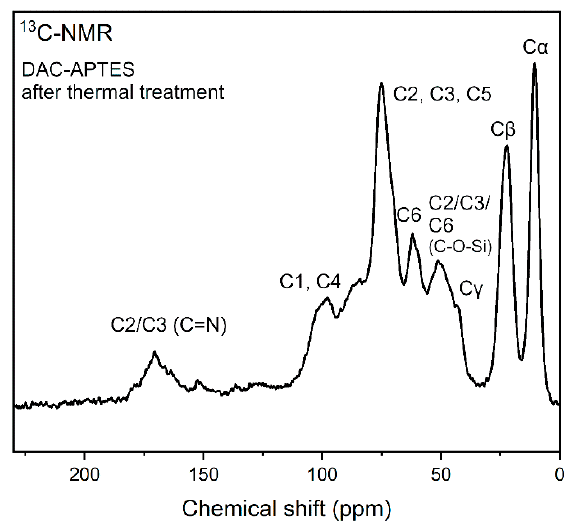
Figure 6. 13 C CP / MAS NMR spectrum of DAC-APTES after thermal treatment. The numbering refers Figure 6. 13 C CP/MAS NMR spectrum of DAC-APTES after thermal treatment. The numbering refers to the structures indicated in Scheme 1: C1–6 from the DAC, a-b and α - β - γ from APTES structures, δ to the structures indicated in Scheme I: C1–6 from the DAC, a-b and α - β - γ from APTES structures, δ : 170.6, 97.7, 75.1, 62, 51.3, 42.9, 22.2, 10.6 ppm.